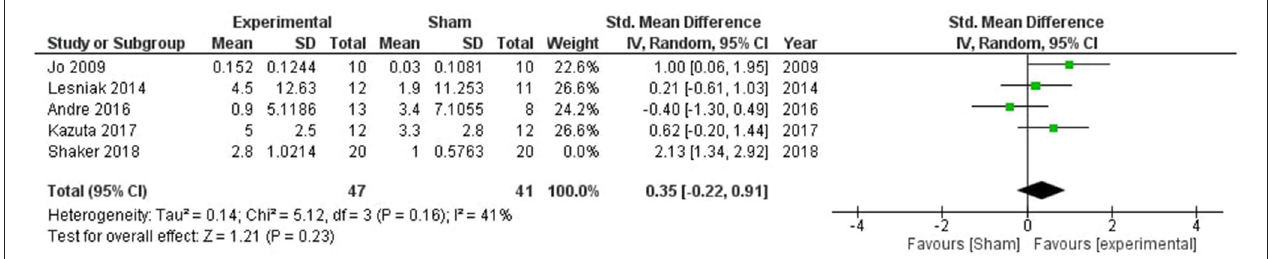
FIGURE 4 | Comparison of the effects of active transcranial stimulation and sham stimulation interventions on working memory. One study was excluded after sensitivity analysis. No stimulation related improvement was observed in the working memory (SMD = 0.35; 95% CI = − 0.22–0.91; p =